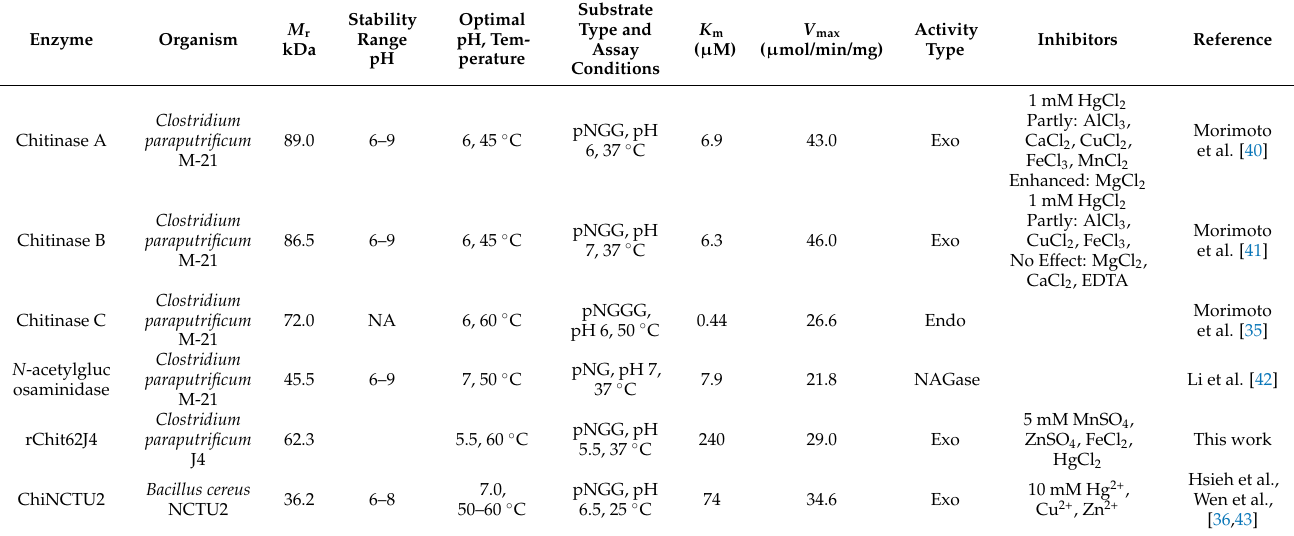
Table 2. Comparison of activity of chitinolytic enzymes related to